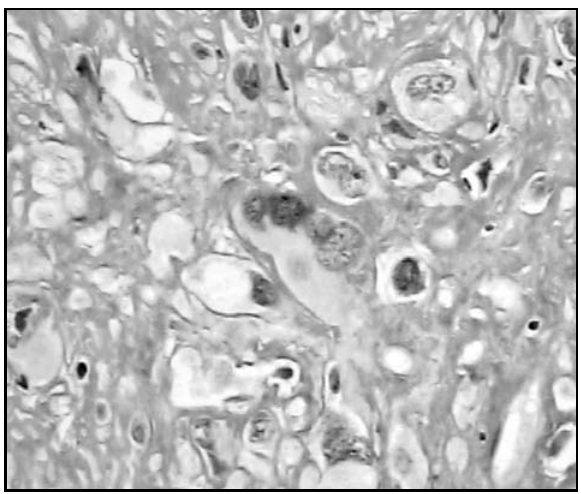
Figura 4 – p53: expressão nuclear em osteossarcoma (IH